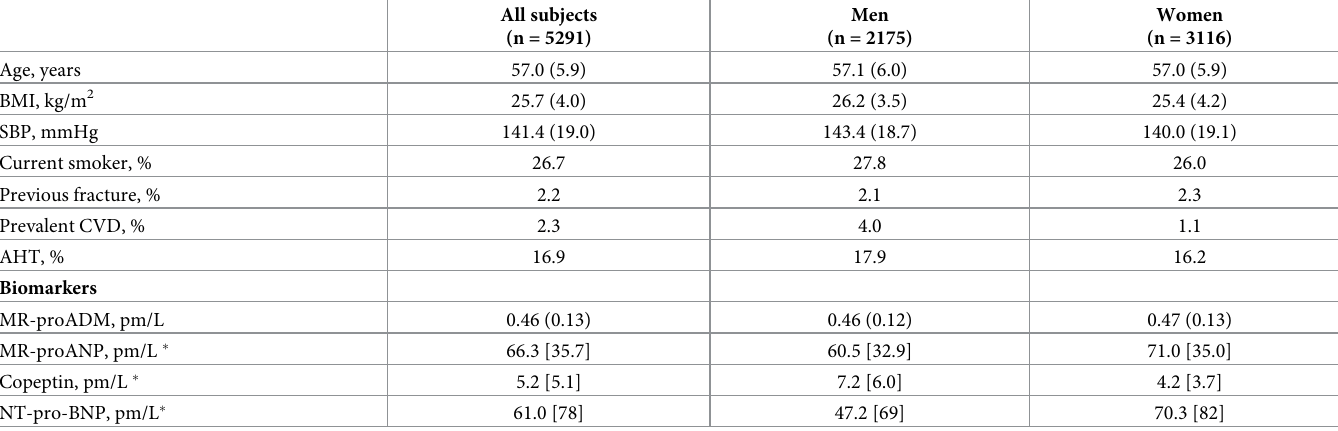
Table 1. Baseline characteristics of study population stratified by